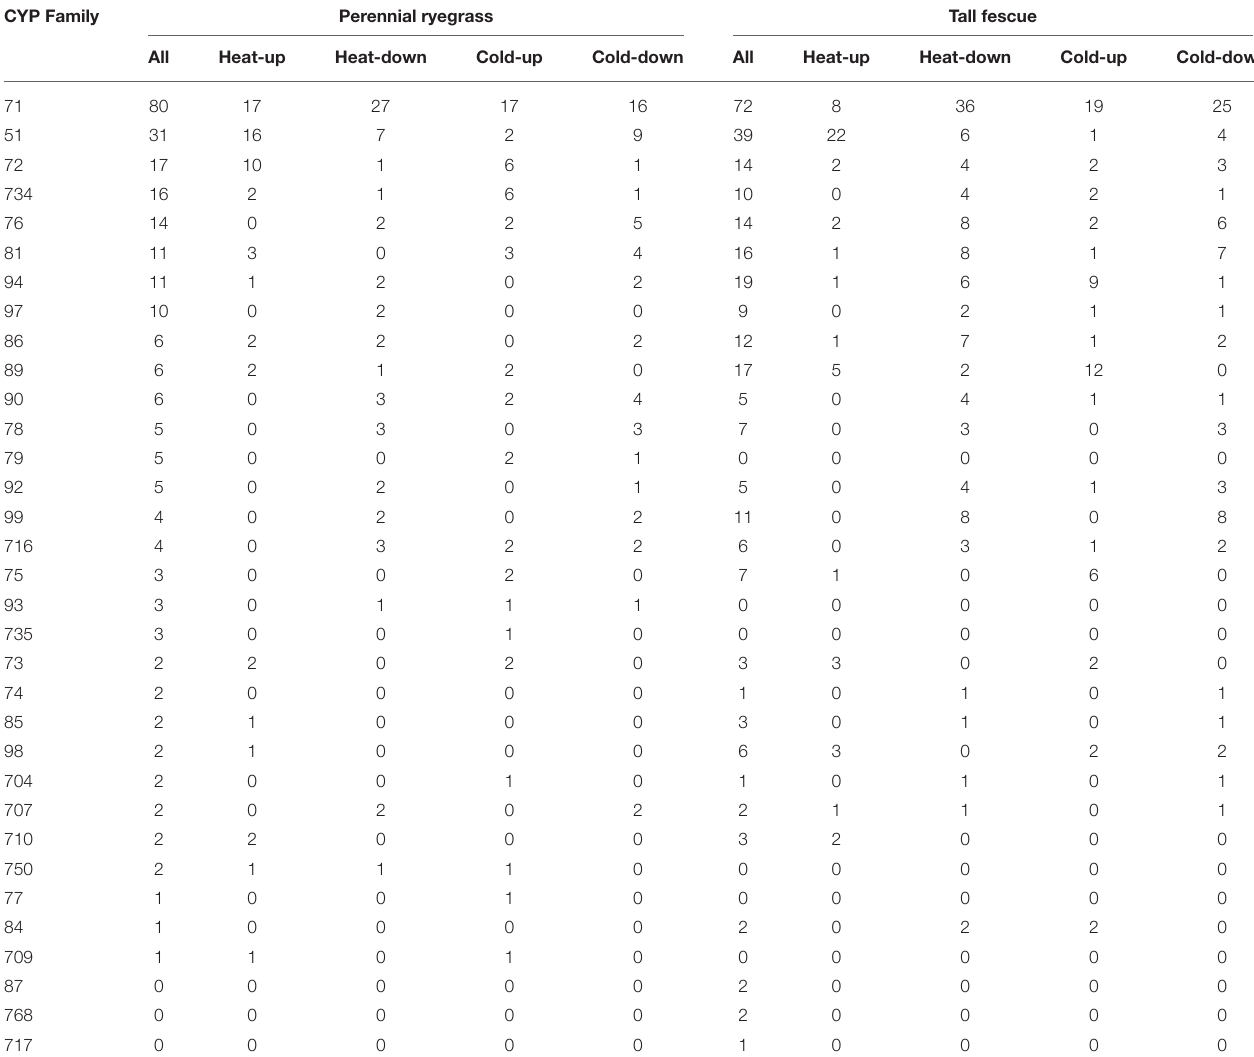
TABLE 1 | Subfamily classification of the predicted P450 transcripts. CYP